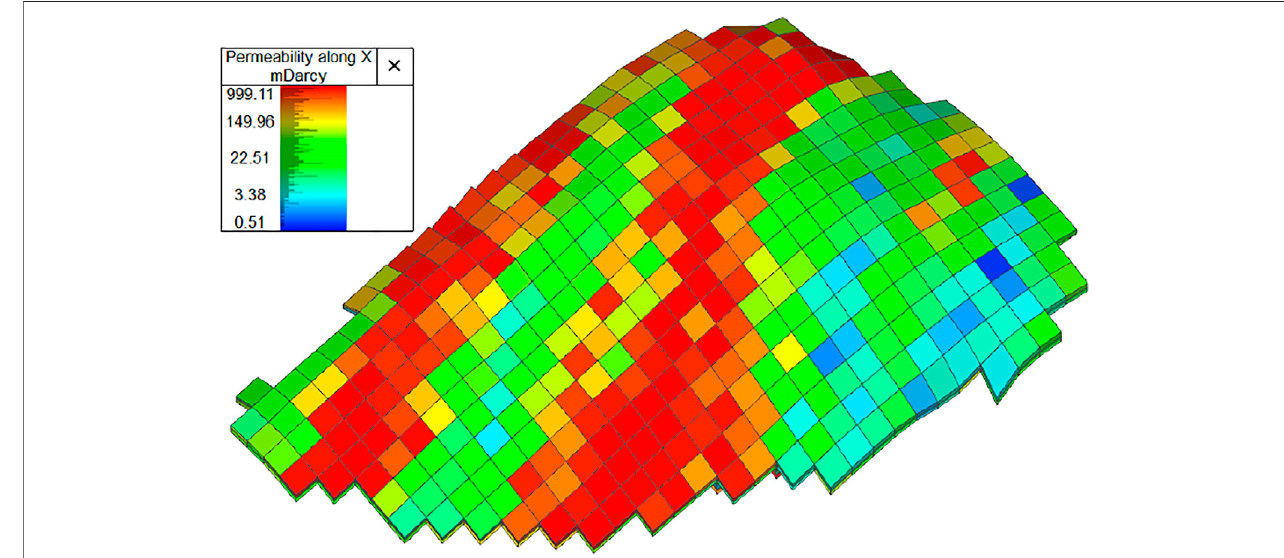
FIGURE 4 | Three-dimensional horizontal permeability fi eld of the PUNQ-S3